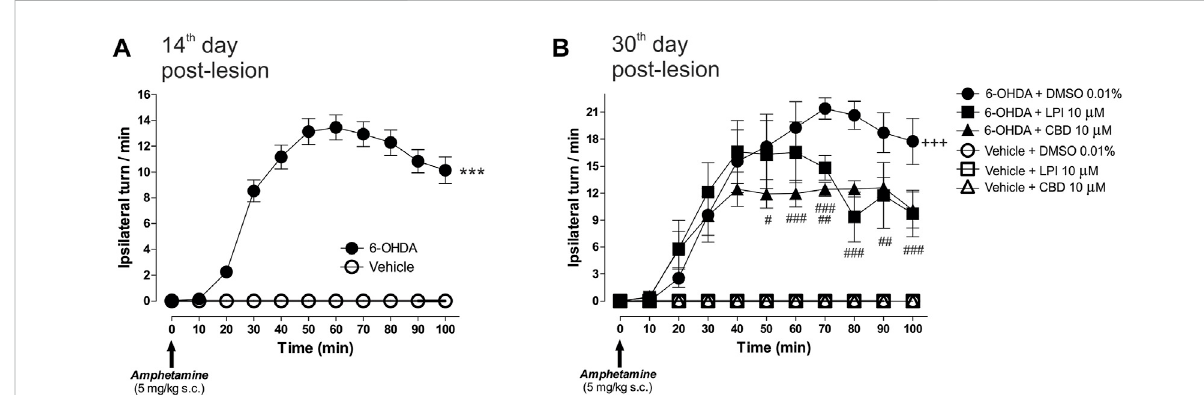
FIGURE 2 The administration of LPI and CBD in the GPe generated lower levels of 6-OHDA-induced motor asymmetry. (A) Amphetamine-induced turning behavior (5 mg/kg) was evaluated 14 days after the 6-OHDA injection into the MFB, with all animals placed into two groups – vehicle and 6- OHDA.The6-OHDAgroupshowedanincreaseinthenumberofipsilateralturnsperminute,incontrasttothevehiclegroup,whichdidnotshowany ipsilateral turns. (B) Six experimental groups were formed in order to evaluate the amphetamine-induced turning behavior presented by the animals after the intrapallidal administration of 1 µL [LPI 10 µM], [CBD 10 µM], or vehicle (DMSO 0.01%) on the 30th day post-lesion. Lower levels of 6-OHDA-induced motor asymmetry in 6-OHDA + LPI and 6-OHDA + CBD groups, a fi nding which contrasts with the 6-OHDA + DMSO. Data are representedasthemean±SEMofipsilateralturnsperminute(10periodsof10 min).*** p < 0.001 vs .vehicle; +++ p < 0.001 vs